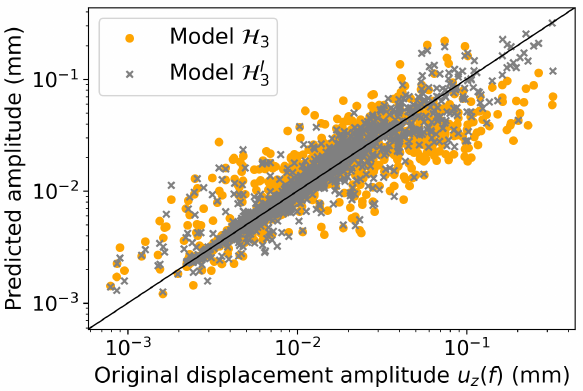
Figure 15. Comparison of prediction accuracy between models H 3 and H I